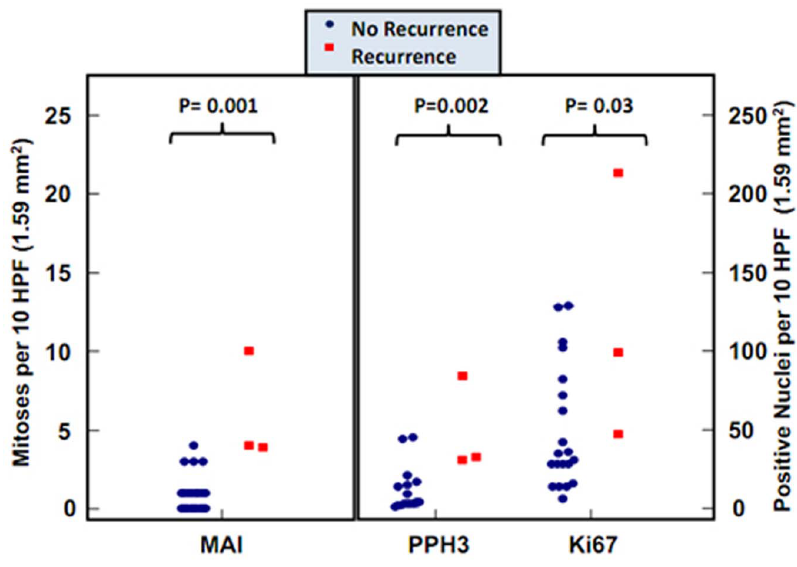
Figure 1. Dot plots of the MAI, Ki-67 and PPH3 in non-recurrent and recurrent ESS cases.